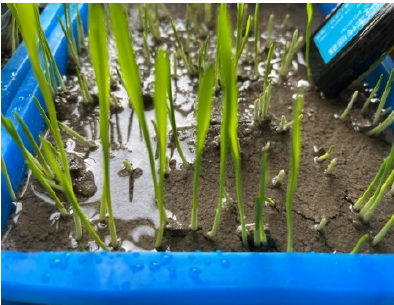
Figure 12. ( a ) Germination ratio versus XG content; ( b ) volumetric moisture content versus XG con- tent; ( c ) germination ratio and volumetric moisture content versus XG content (pH = 2); ( d ) germi- nation ratio and volumetric moisture content versus XG content (pH = 7); ( e ) germination ratio and volumetric moisture content versus XG content (pH = 12).